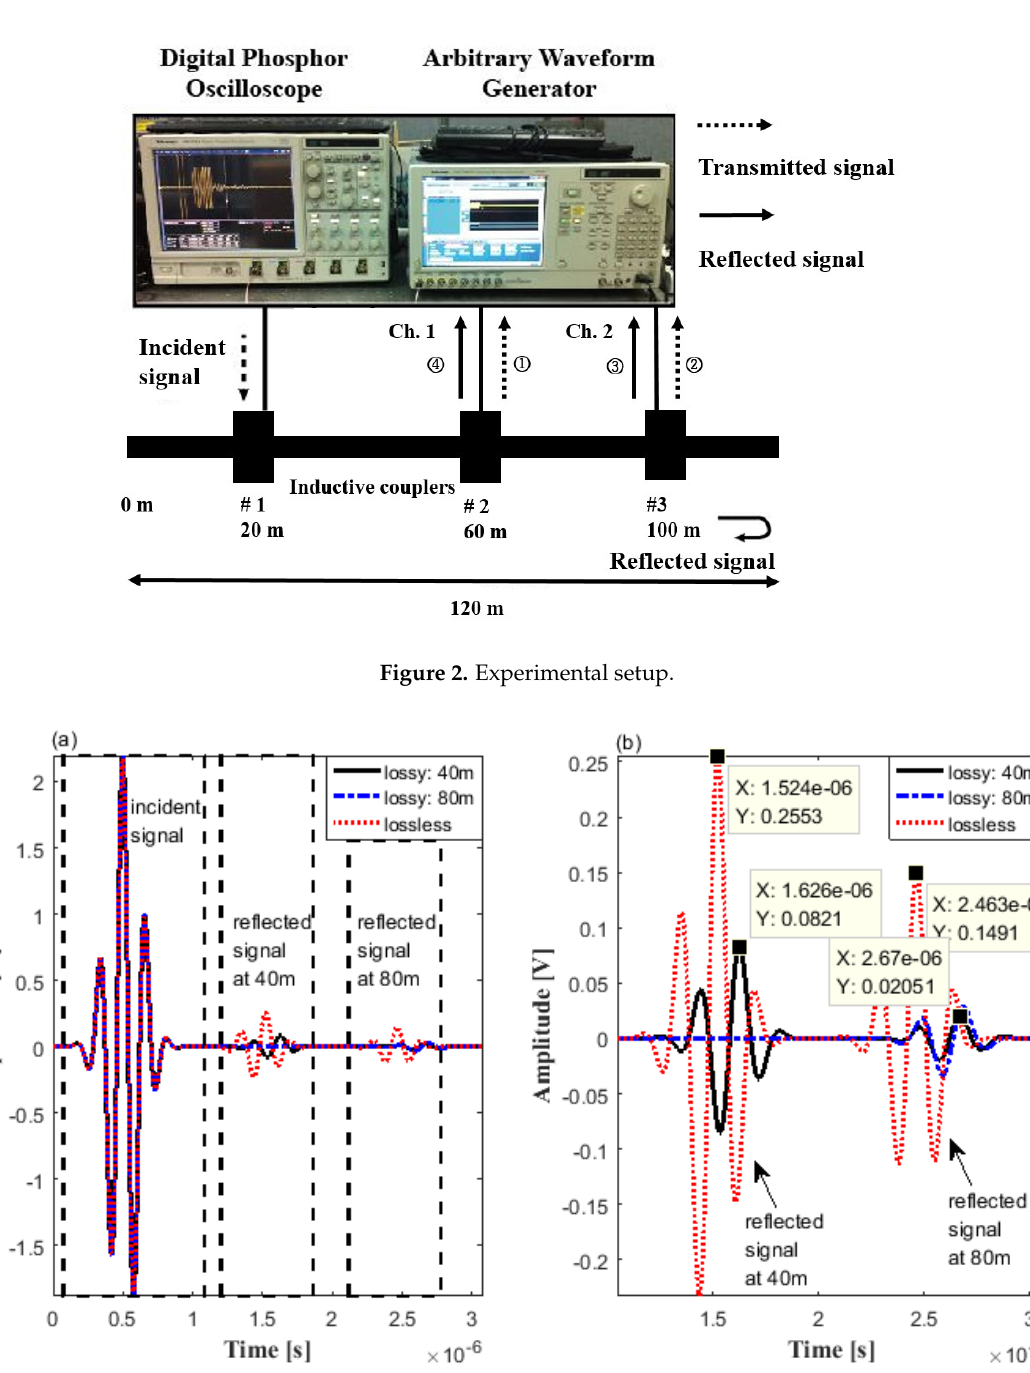
Figure 3. The results of acquired signals: 40 m lossy cable, 80 m lossy cable, lossless cable ( a ) total signal; ( b ) reflected